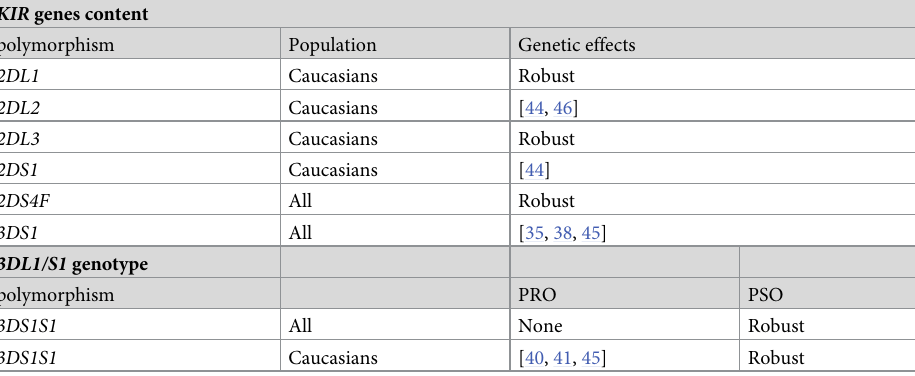
Table 5. Sensitivity analysis outcomes.